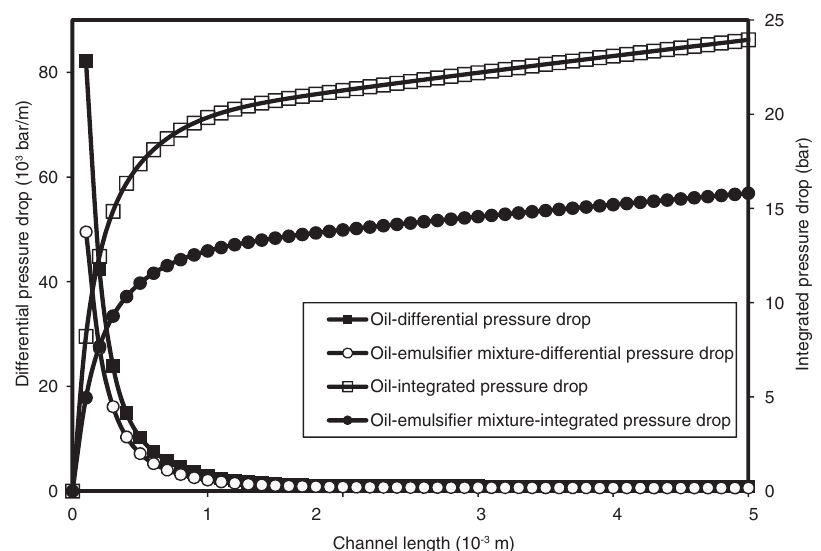
Figure 7 Pressure loss of Oil (Oil-emulsifier mixture) flow in an ideal co-current flow µHX (only the pressure drop along the first 5 mm of the channel length is shown).